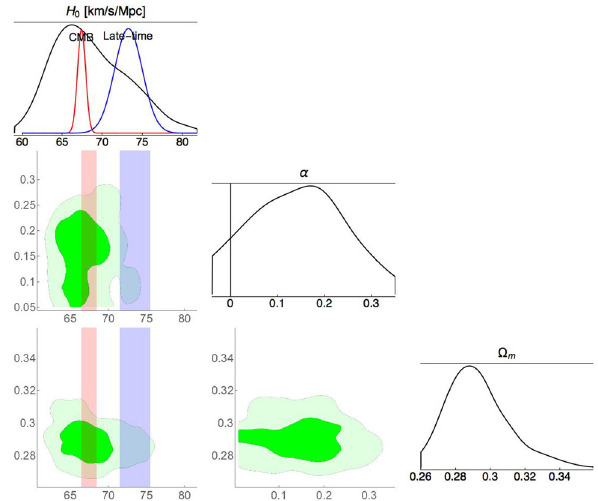
Fig. 2 1D and 2D posterior distributions of H 0 ,α,(cid:15) m probed by the latetimemeasurement(Pantheondatasetof1048SNeIa).Themean H 0 ( ± 1 σ ) of qCDM model is approximately equals to 67 ± 4 km/s/Mpc; the referenced H 0 of Planck [3] and the referenced H 0 of the late time measurements [5] are shown in red and blue